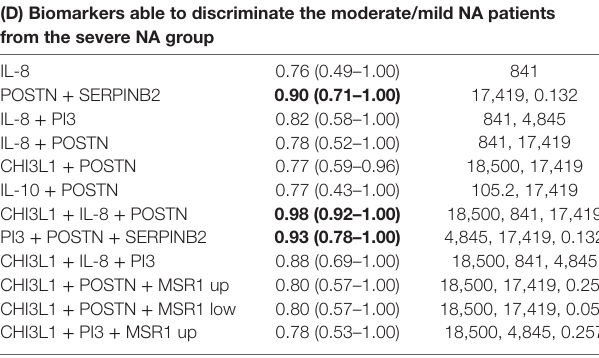
Summary of the best options for discriminating each condition, obtained from the ROC curve analysis of protein expression from each of the nine biomarkers, alone or in combination. C: control group. NA: nonallergic asthma group. MM: group of subjects with moderate–mild asthma. S: group of subjects with severe asthma. MSR1 low: MSR1’s lower band protein expression. MSR1 up: MSR1’s upper band protein expression. Threshold means the proteic levels of each biomarker able to discriminate each condition, with the AUC indicated. In bold are marked the options with the best statistical power (CI 95% between 0.7 and 1).